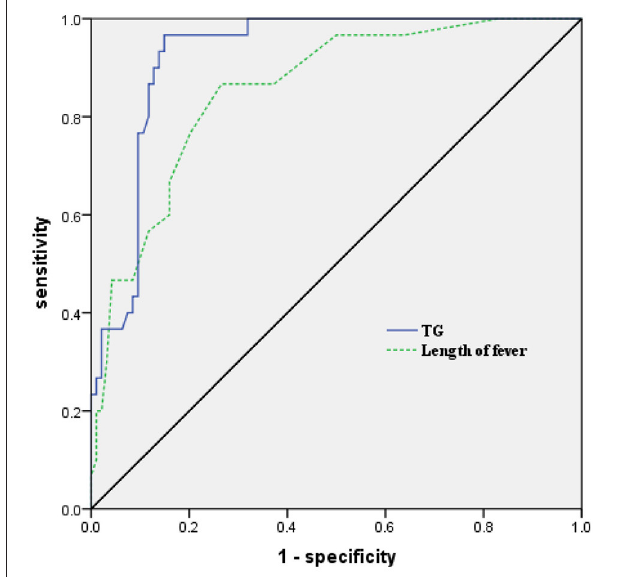
FIGURE 2 | Receiver operating characteristic (ROC) curve analysis of TG and the length of fever in predicting the development of HLH in children with SAP. TG, triglycerides; HLH, hemophagocytic lymphohistiocytosis; SAP, severe adenovirus pneumonia.